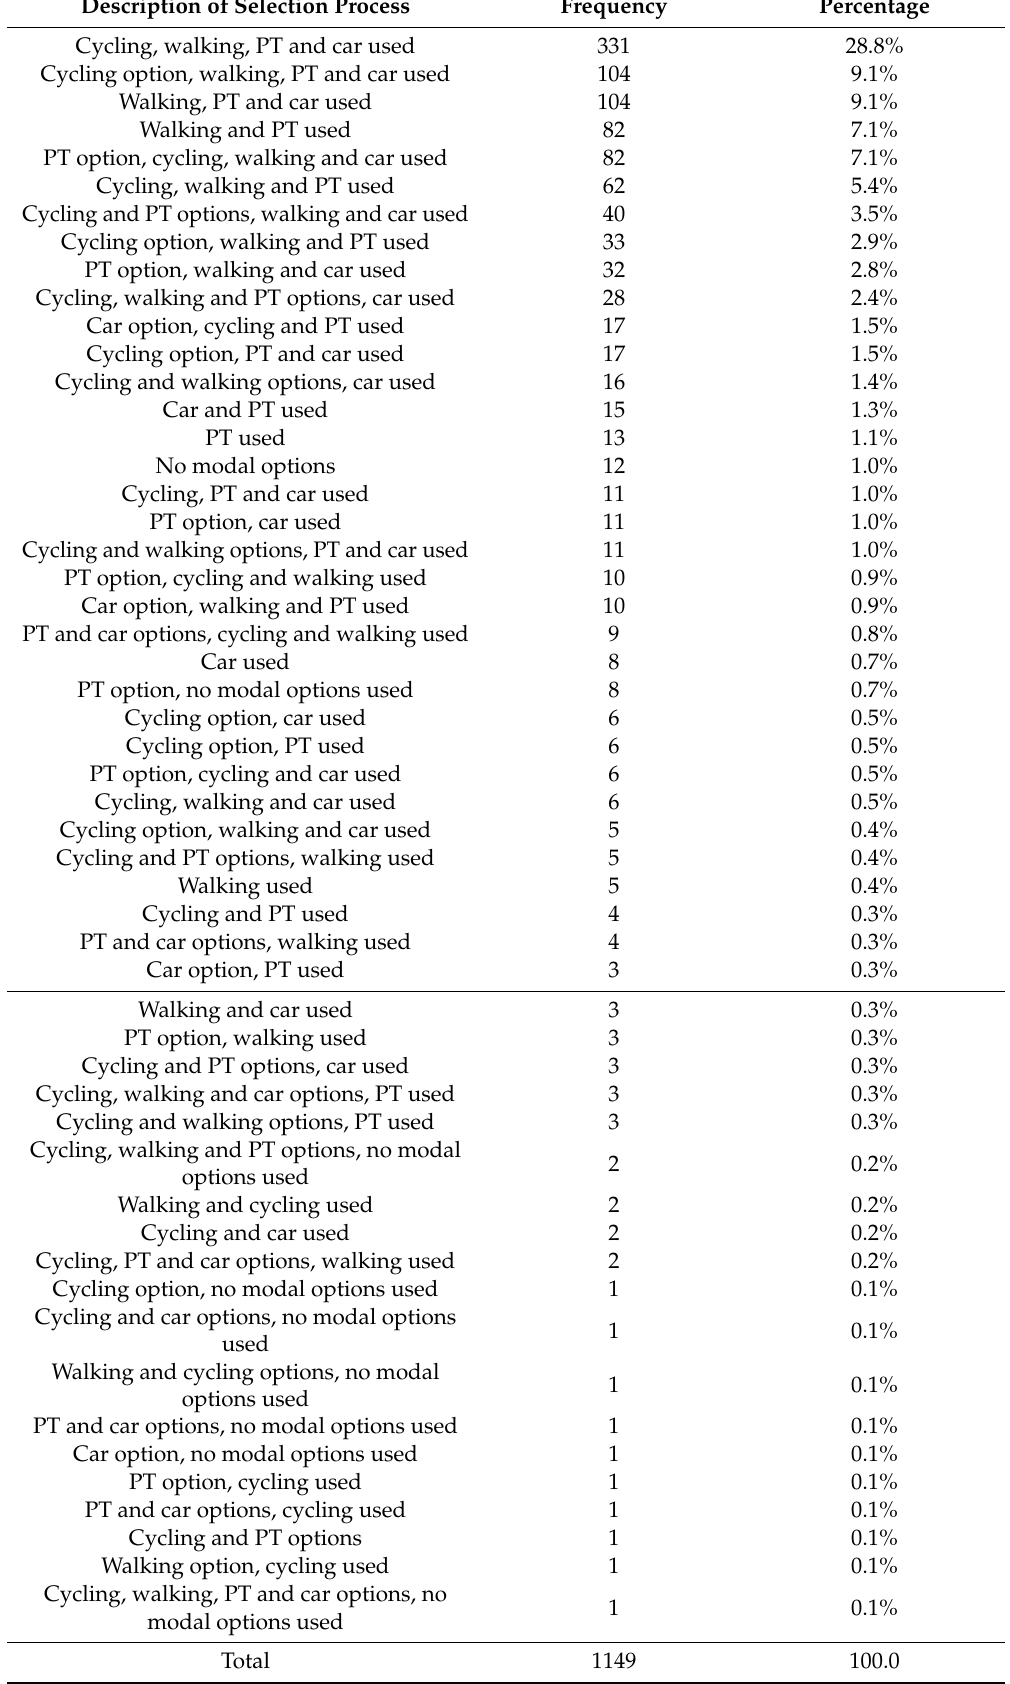
Table 1. Frequency of the di ff erent modal choice processes. Description of Selection